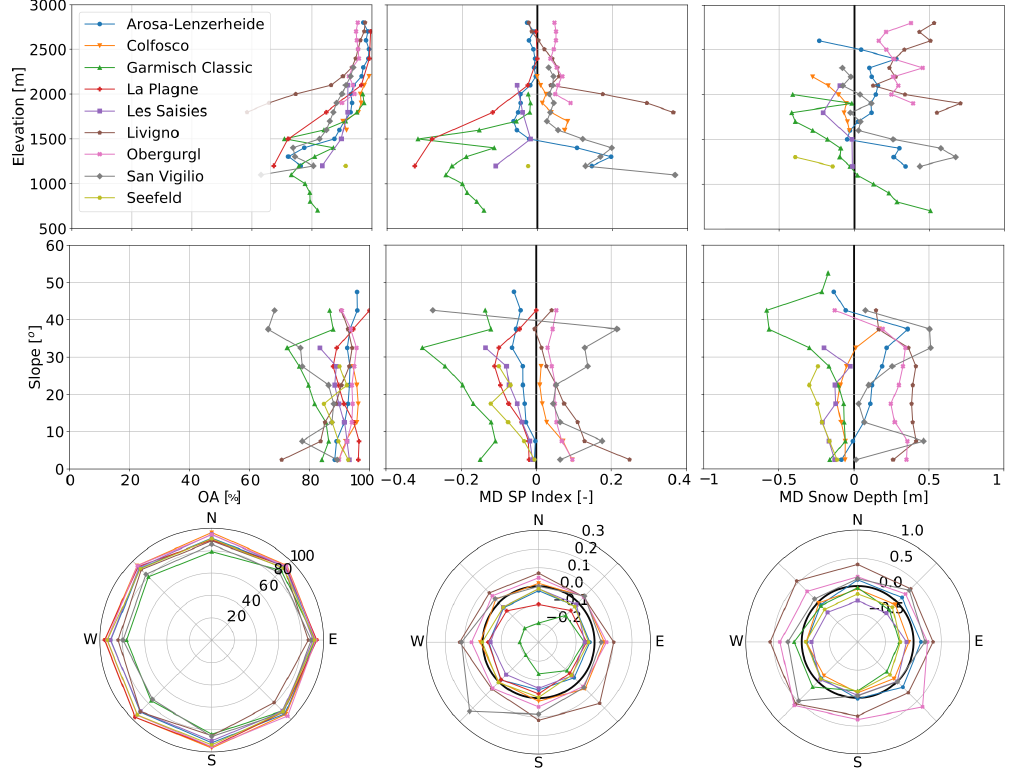
Figure 4. Comparison for 100m elevation bands, 5 ◦ slope bands, and 45 ◦ aspect bands for (left) overall accuracy (OA) between simulation and S2 data, (middle) mean deviation (MD) in snow persistence index between S2 data and simulation, and (right) mean deviation (MD) value between the simulated and GNSS-measured snow depth data. All metrics are computed for snow on the pistes